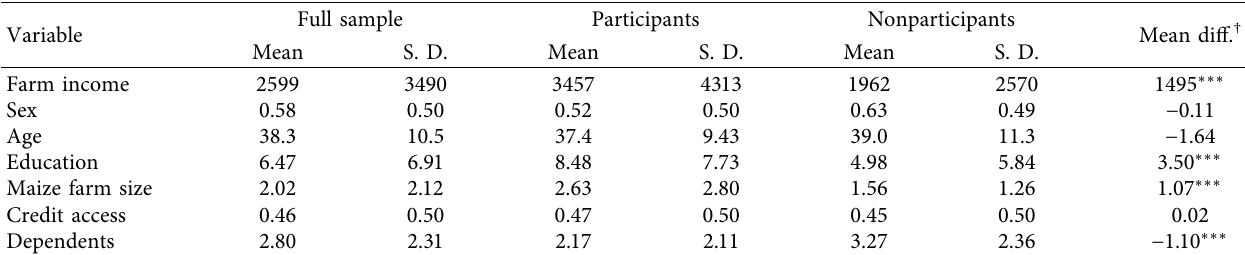
Table 2: Descriptive statistics of the variables used for the